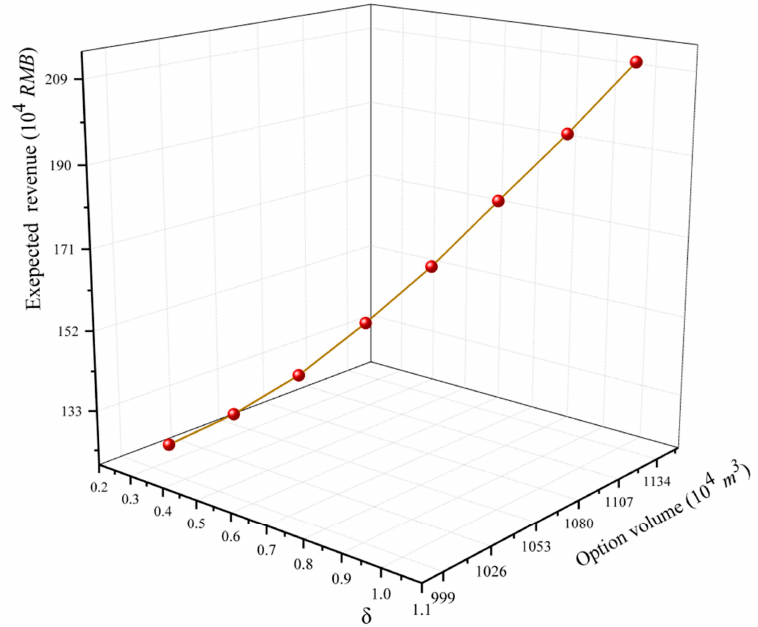
Figure 7. The relationship among parameter ( δ ), the optimal options trading volume and the expected return of the optimal options. Table 5. The results of experiment scheme 2.